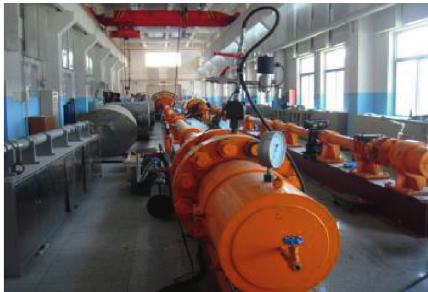
Figure 6: Launch platform of the 152mm compressed-gas